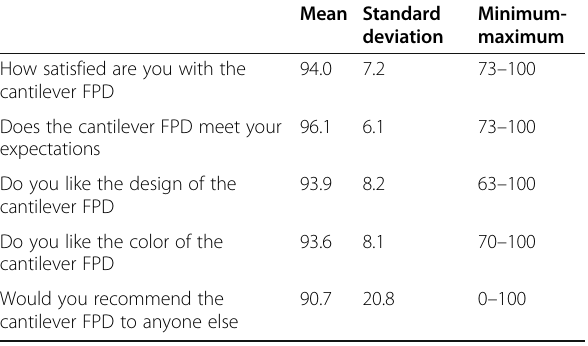
Table 5 Patient satisfaction questionnaire with VAS